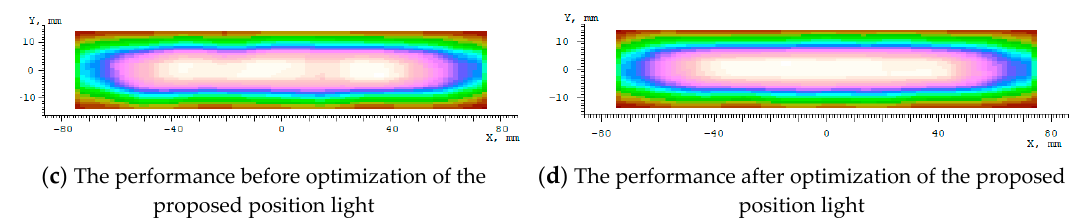
Figure 9. ( a , b ) The intensity distribution of the proposed position light ( c , d ) The illuminance distribution